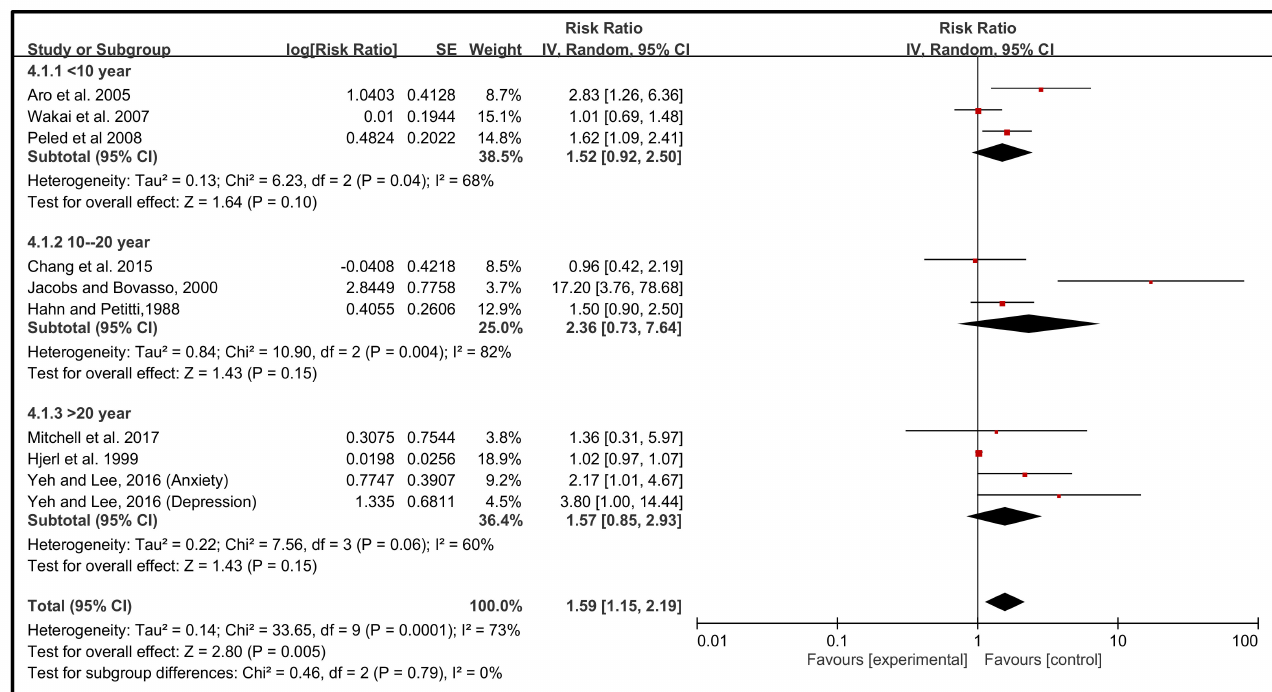
Figure 4. Geographical distribution. The results were stratified by different nations [43–46,48–50].